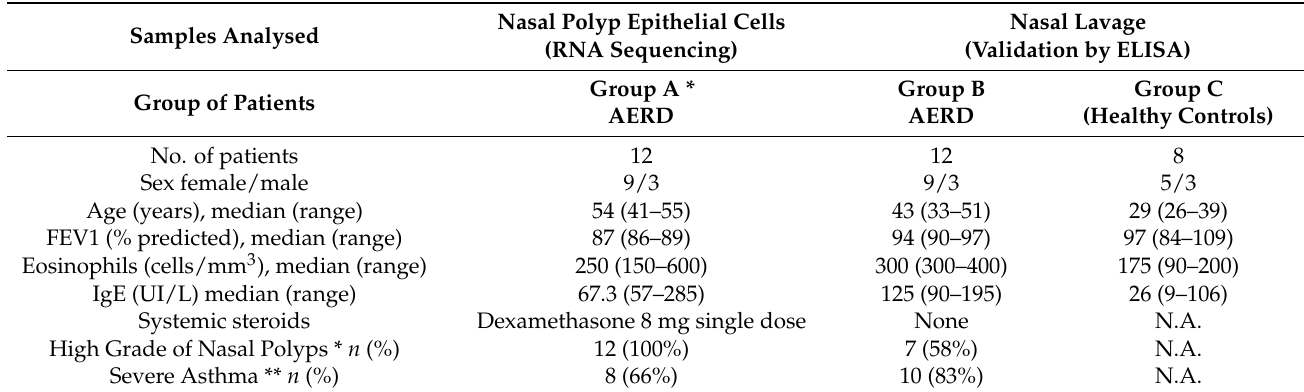
Table 1. Clinical characteristics of